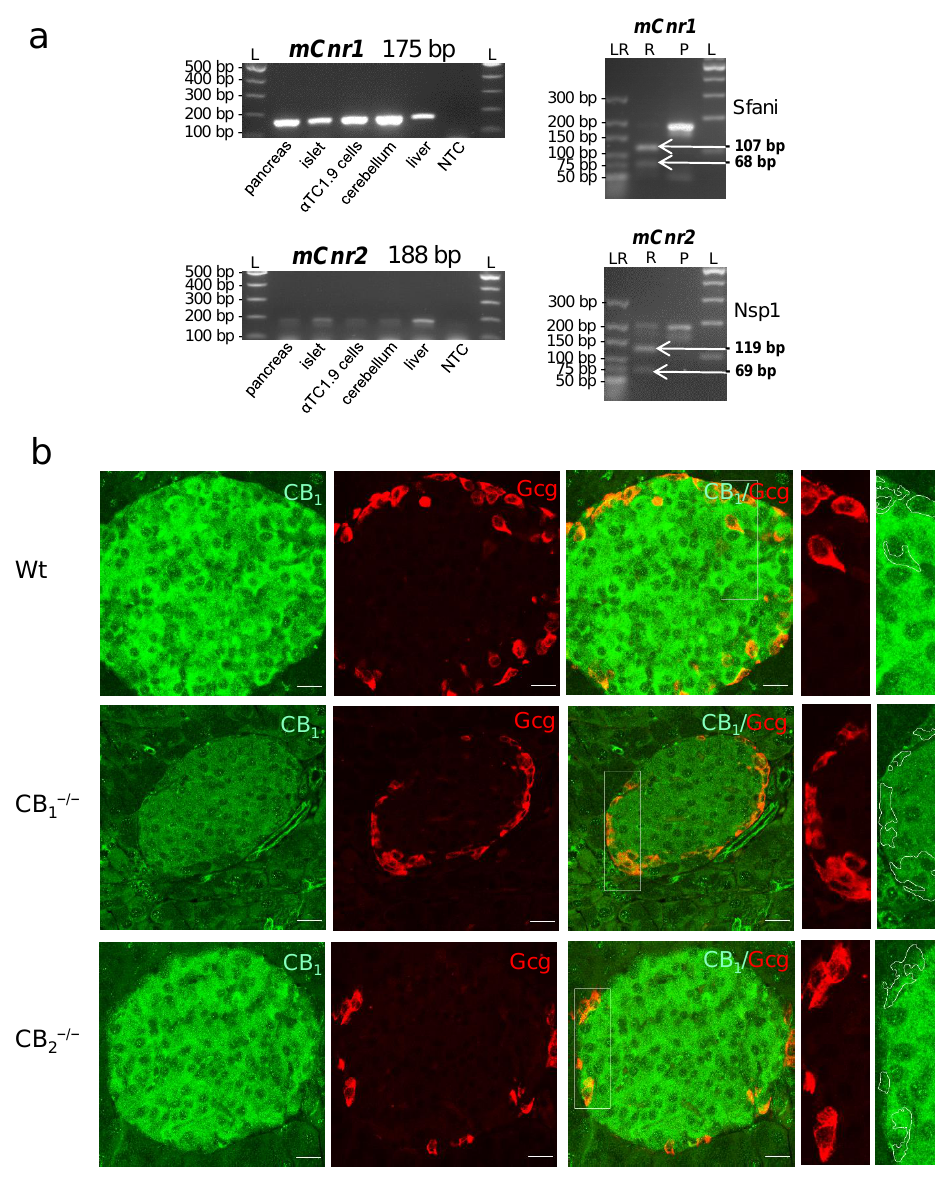
Figure 1. ( a ) Expression of cannabinoid receptor type 1 ( Cnr1 ) and 2 ( Cnr2 ) mRNA in mouse (m) tissues. RT-PCR followed by gel electrophoresis (left column) revealed the expression of mCnr1 and mCnr2 transcripts in different mouse organs, particularly, in pancreatic tissue including the islets of Langerhans and the mouse alpha-cell line α TC1.9. Restriction digestion of the 175 bp mCnr1 amplicon resulted in defined fragments with molecular sizes of 107 and 68 bp (right column). The restriction analysis of the 188 bp mCnr2 showed defined fragments with molecular sizes of 119 and 69 bp (right column). NTC: nontemplate control; L: 100 bp ladder; LR: low-molecular-range ladder; P: Cnr1 or Cnr2 amplification product; R: restriction fragments. ( b ) Immunohistochemical staining of cannabinoid receptor type 1 (CB 1 ) in the pancreatic tissue of wild-type (Wt) mice displayed specific labelling of an islet. Glucagon (Gcg, red) and CB 1 (green) double-immunolabelling demonstrated the presence of CB 1 , not only in beta-cells, but also in alpha-cells. At higher magnifications of alpha-cells (2 fold, right panels), weaker CB 1 staining was evident. No immunohistochemical staining of CB 1 was detected in pancreatic islets of CB 1 − / − knockout mice. In all cases, confocal optical sections were merged and are representative for pancreatic islets of the whole pancreatic tissue from three mice per group. Scale bar 20 µm.